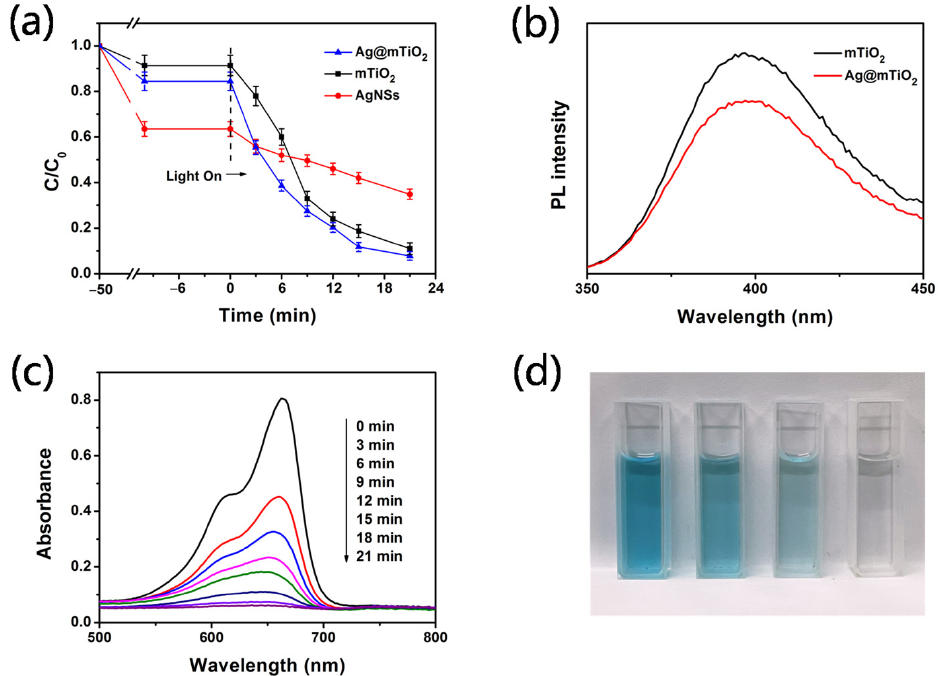
Figure 3. ( a ) Photocatalytic degradation of MB by different catalysts. ( b ) PL spectra of mTiO 2 and Ag@mTiO 2 nanoparticles (excitation wavelength is 225 nm). ( c ) UV-vis absorption spectra of MB solution for different times. ( d ) Photograph of MB solution at different times catalyzed